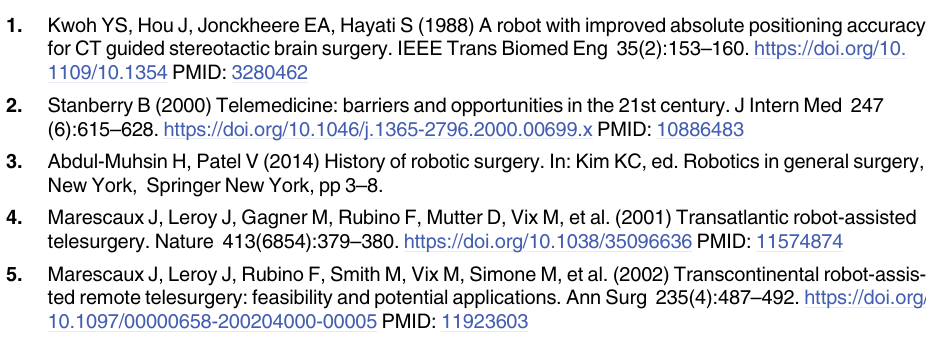
S3 Fig. Total number of faults of each task. No one made any faults in Task A. In Task C, no minor faults were observed. (TIF) S4 Fig. Boxplot comparing movement distance of forceps between Group 3 with delay and Group 1 or Group 2 without delay. G1(0), Group 1 without delay; G2(0), Group 2 without delay; G3(0), Group 3 without delay; G3 70, Group 3 with delay of 70 ms; G3 100, Group 3 with delay of 100 ms; G3 150, Group 3 with delay of 150 ms; G3 200, Group 3 with delay of 200 ms; G3 300, Group 3 with delay of 300 ms. (TIF) S1 Dataset.